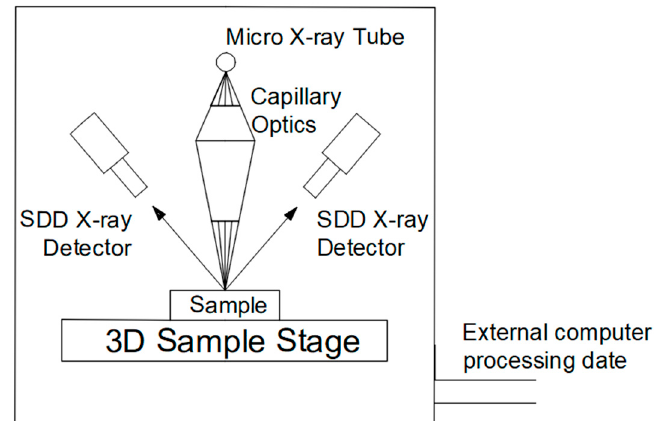
Figure 2. Schematic diagram of the structure of the micro-beam X-ray fluorescence spectrometer.